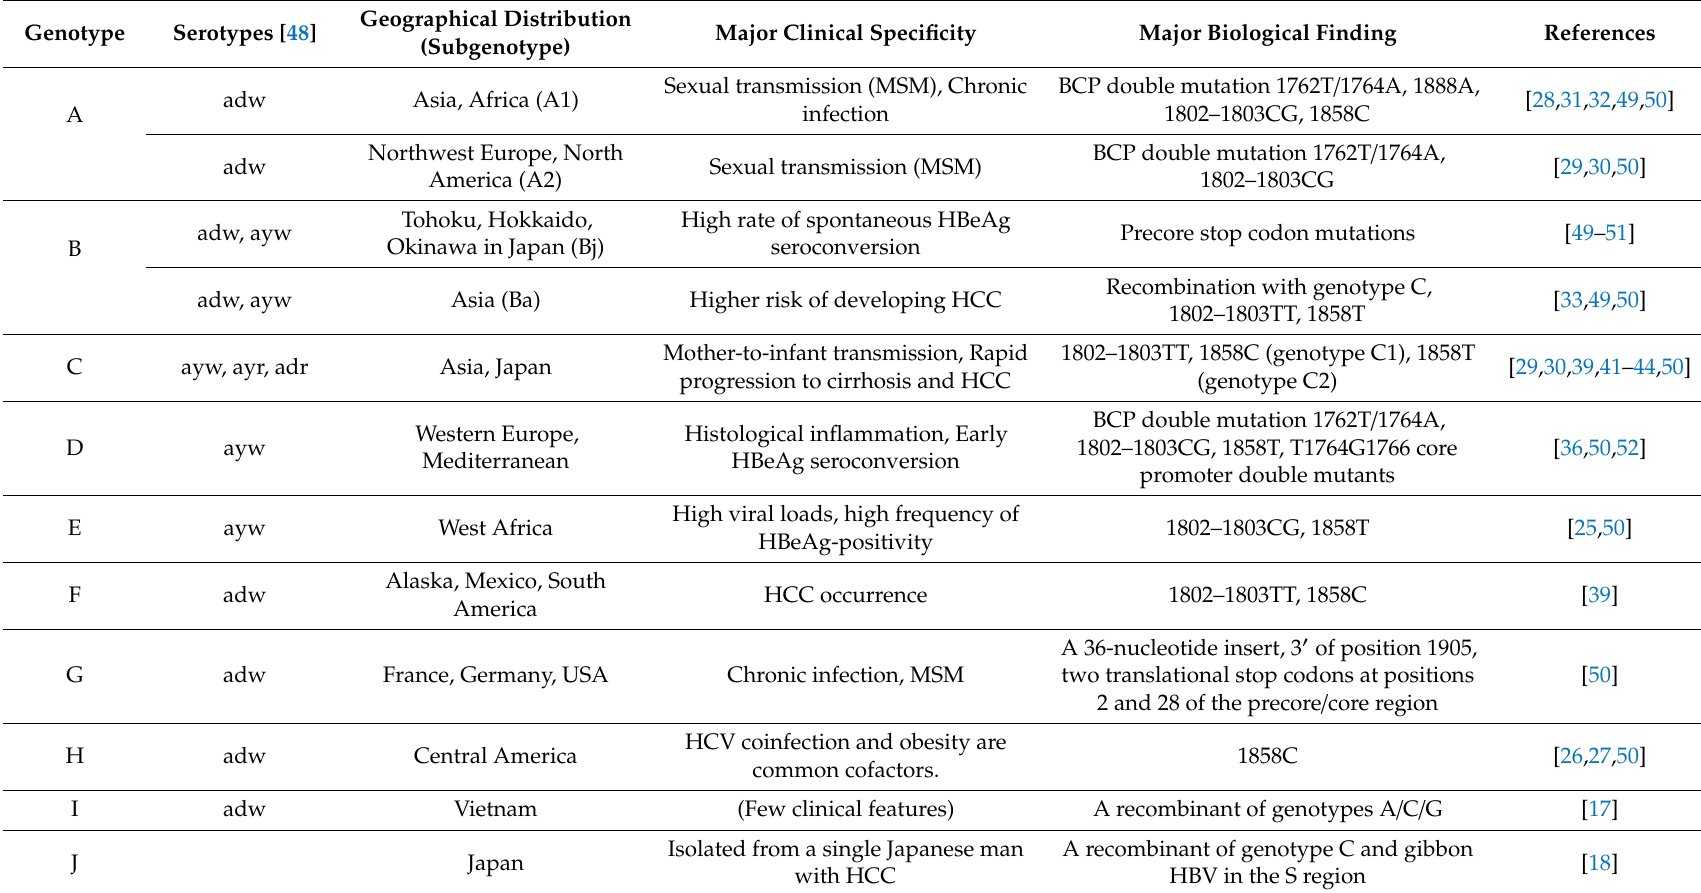
Table 1. The features and geographical distribution of each genotype